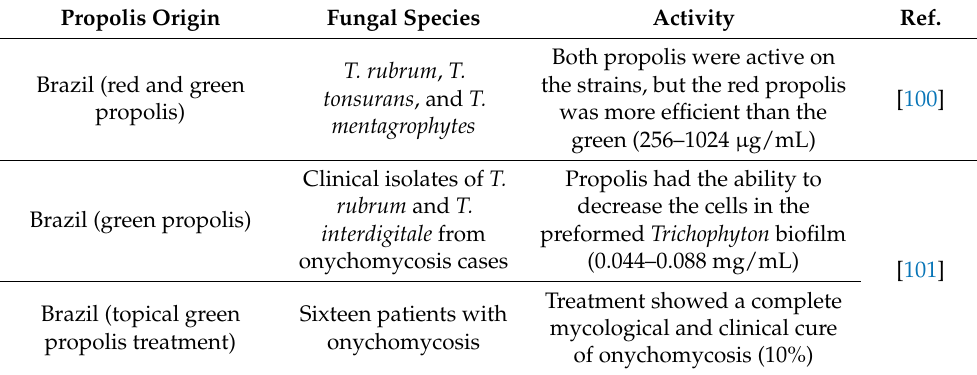
Table 10. Effect of propolis on different species of Trichophyton